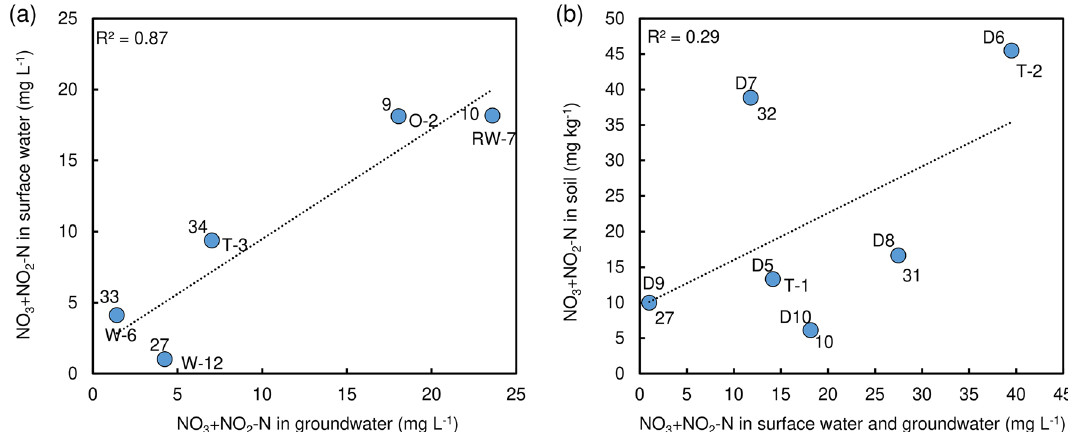
Figure 10. Nitrate concentration relationships for groundwater, surface water, and